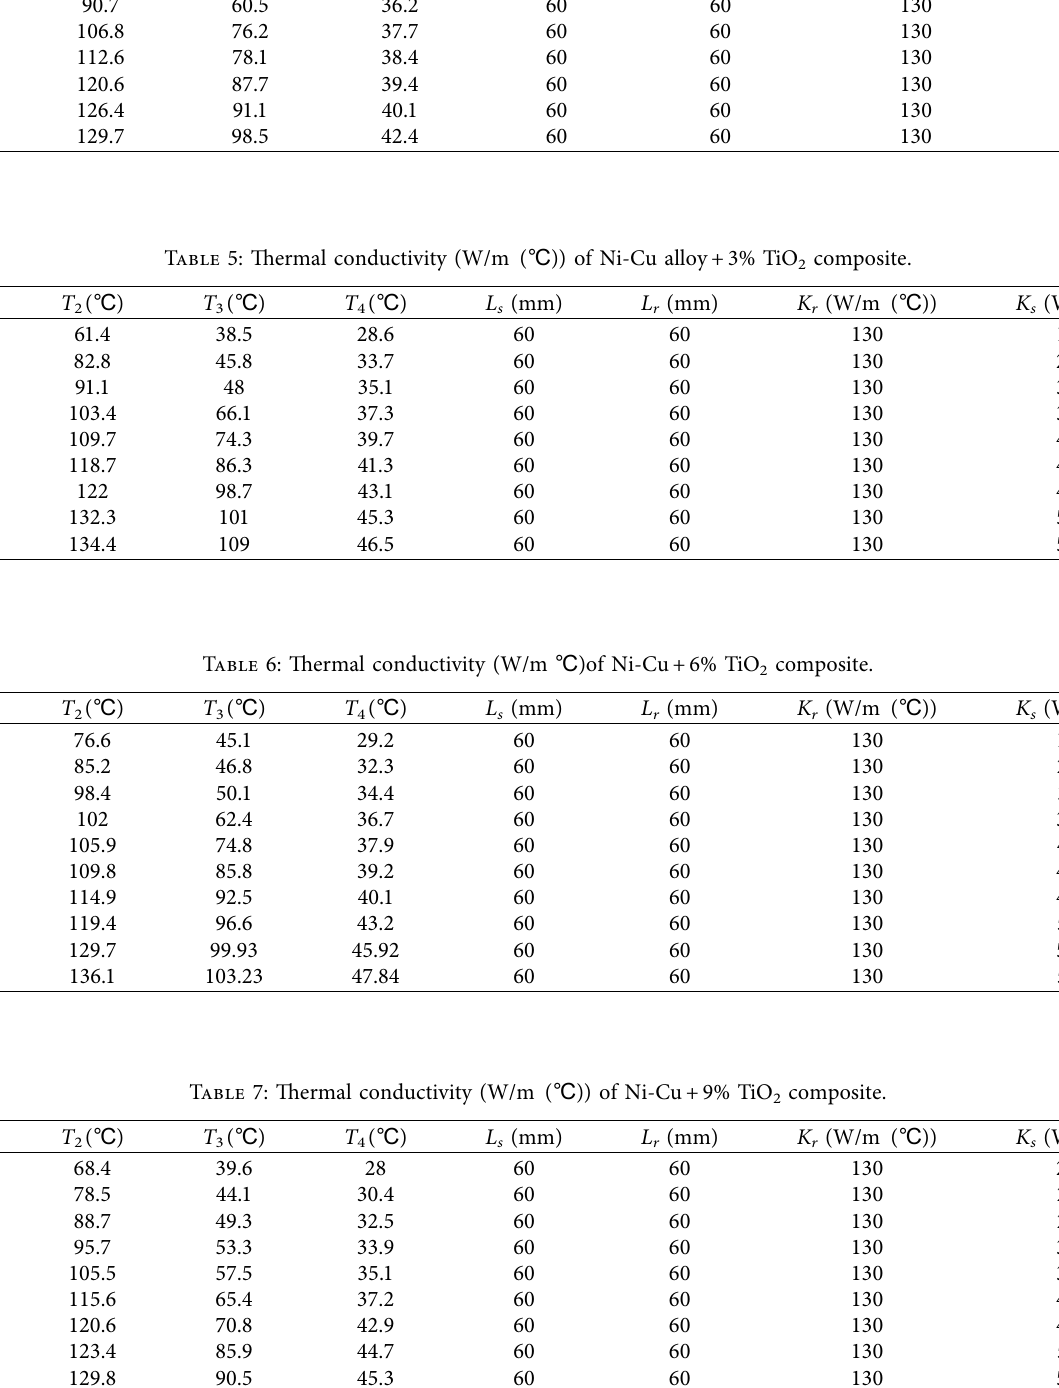
Table 4: Thermal conductivity (W/m ( ℃ ) ) of Ni-Cu alloy (unreinforced) composite.